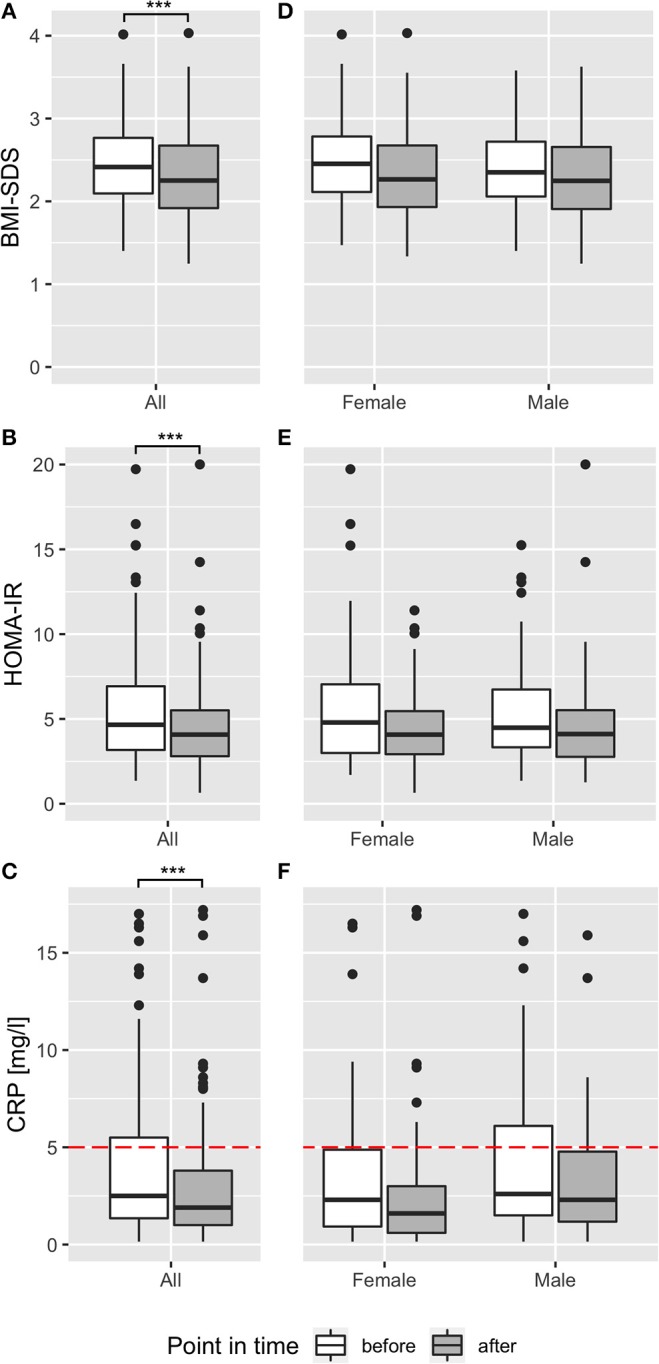
Effect of multidisciplinary intervention on body composition, insulin resistance, and inflammation. Effect of intervention on BMI-SDS (A,D), HOMA-IR (B,E), and CRP (C,F) before (white) and after (dark gray) multidisciplinary treatment are shown as boxplots for the whole participants' cohort (A–C) and stratified for sex (D–F). Red dotted lines show reference ranges, where applicable. ***p < 0.001.